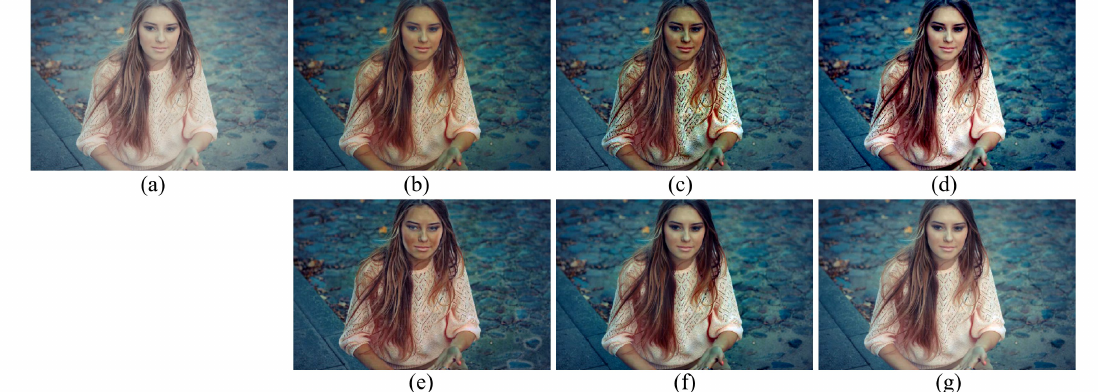
Figure 10. Experimental results of haze removal using the proposed and existing methods: ( a ) an input haze image [4], reproduced with permission from [4], IEEE, 2014, ( b ) He’s method [1], ( c ) Meng’s method [9], ( d ) Berman’s method [8], ( e ) Zhu’s method [2], ( f ) Ren’s method [6], and ( g ) the proposed method.